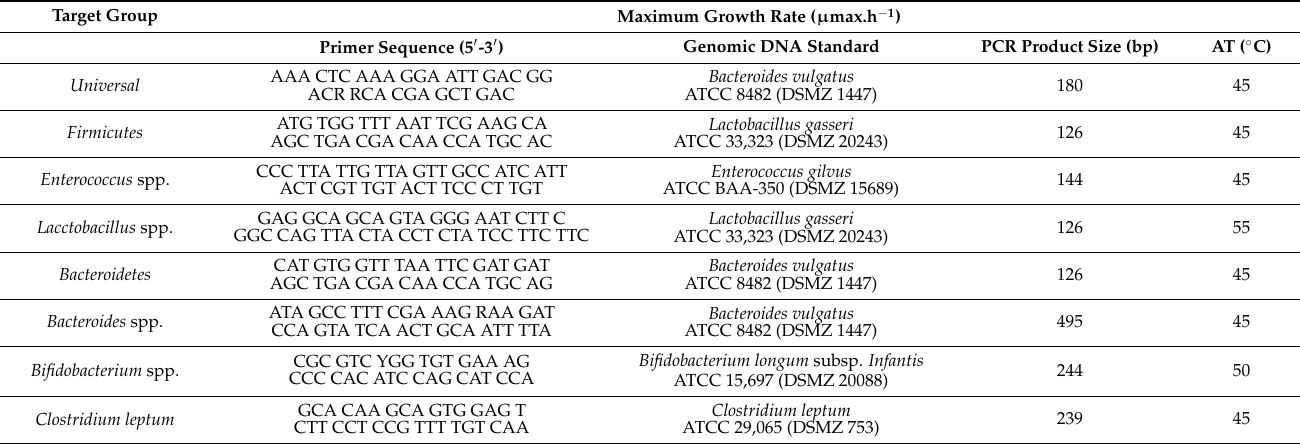
Table 1. Primer sequences and real-time PCR conditions used for gut microbiota